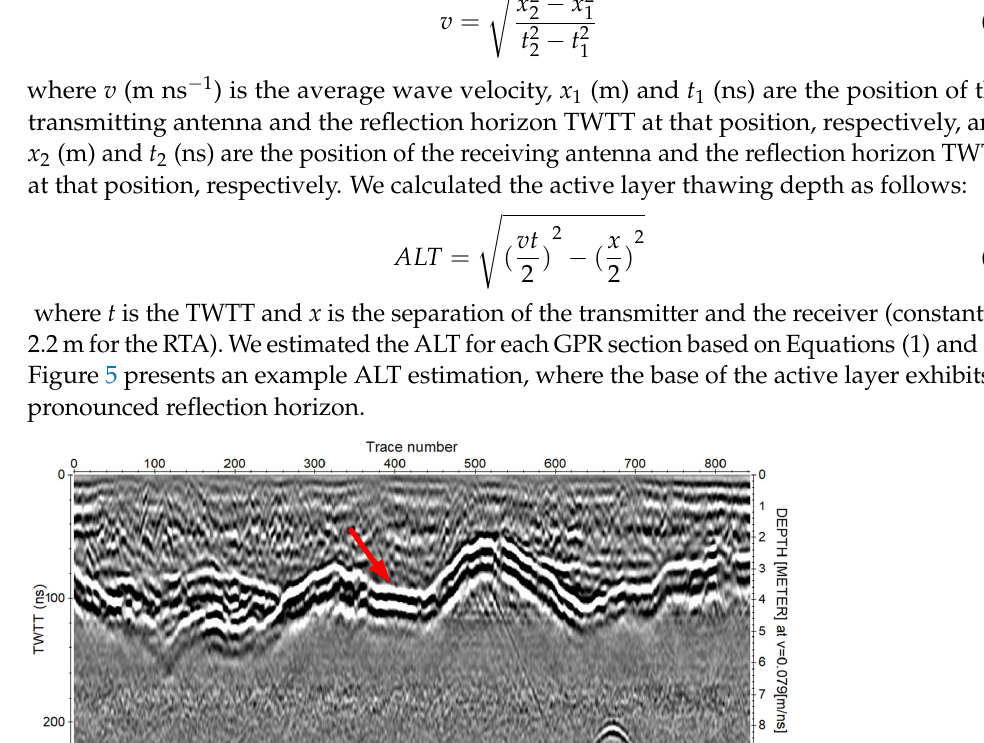
Figure 4. Picking average wave velocity of the active layer in Reflexw software: ( a ) the wave velocity broken-line graph of different soil layers, ( b ) electromagnetic signal graph of the common midpoint (CMP) data, and ( c ) intensity graph of the electromagnetic signal.